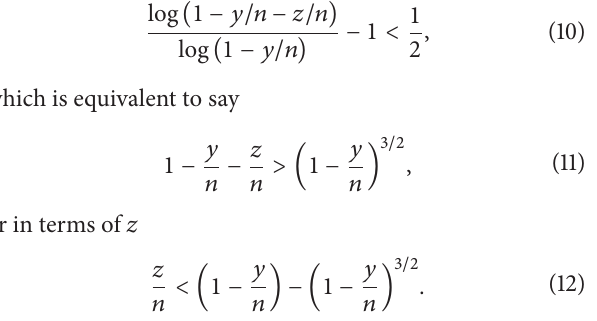
The maximum likelihood estimates of 𝑐 and 𝛽 (̂𝑐 are defined as the values that maximize the log-likelihood